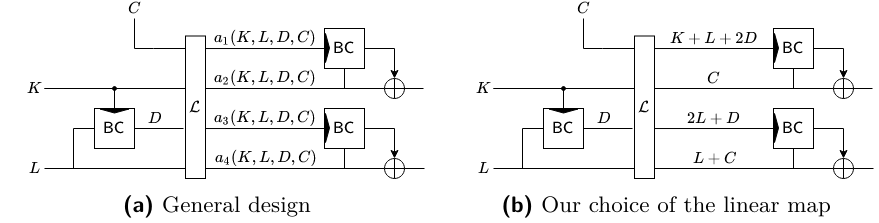
Figure 17: Mennink’s optimally secure generic compression